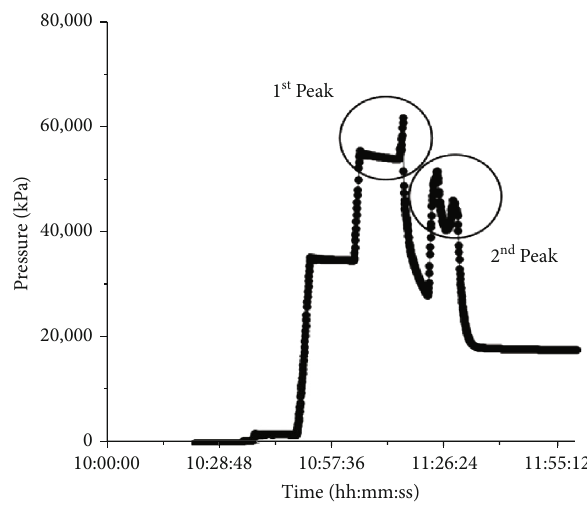
Figure 5: Recorded pressure data of the